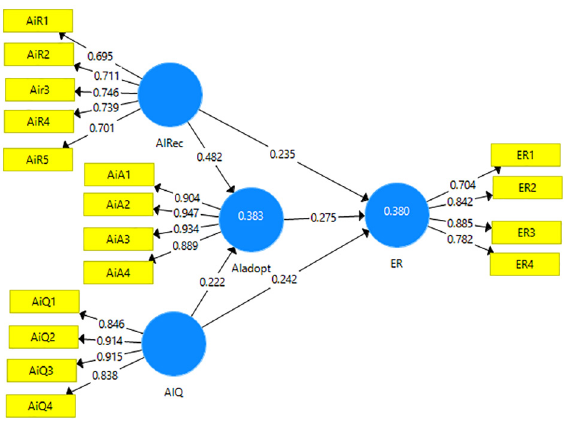
Figure 2. Measurement model